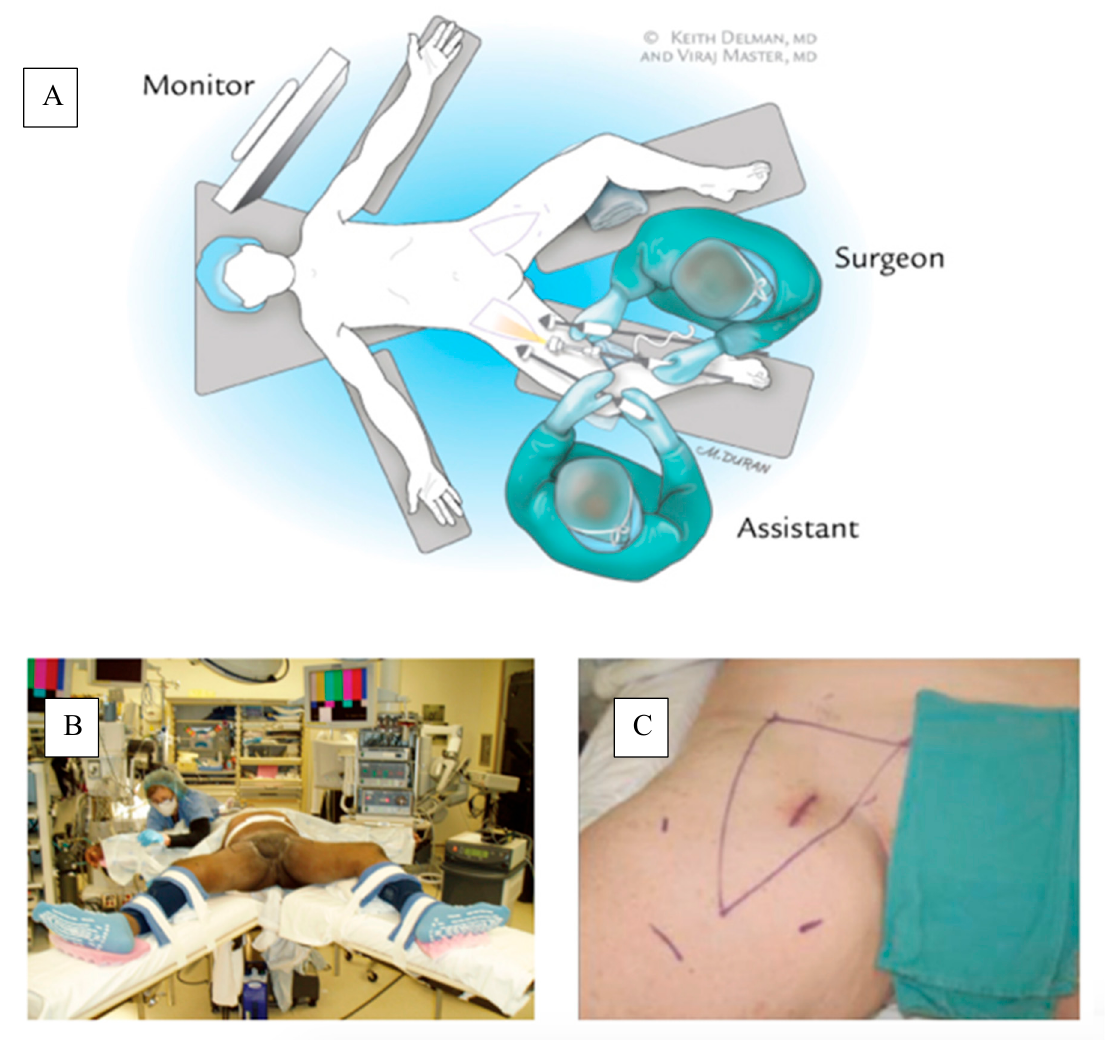
Figure 2. ( a ) Patient and surgeons’ position during the operation. ( b ) Patient is placed on split leg table. ( c ) Landmarks are marked including port sites and femoral triangle. Copyright owned by Master et al.